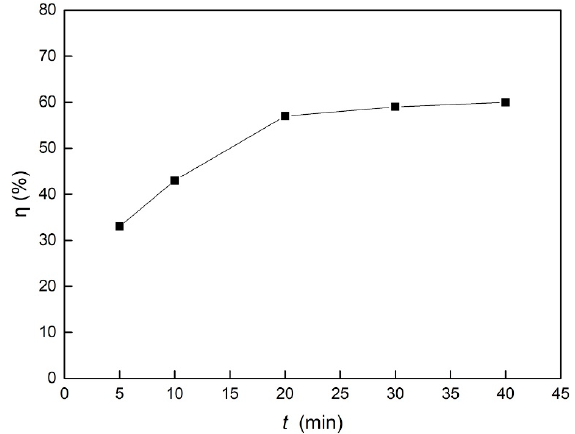
Figure 9. Effect of adsorption time on the catechol removal rate.